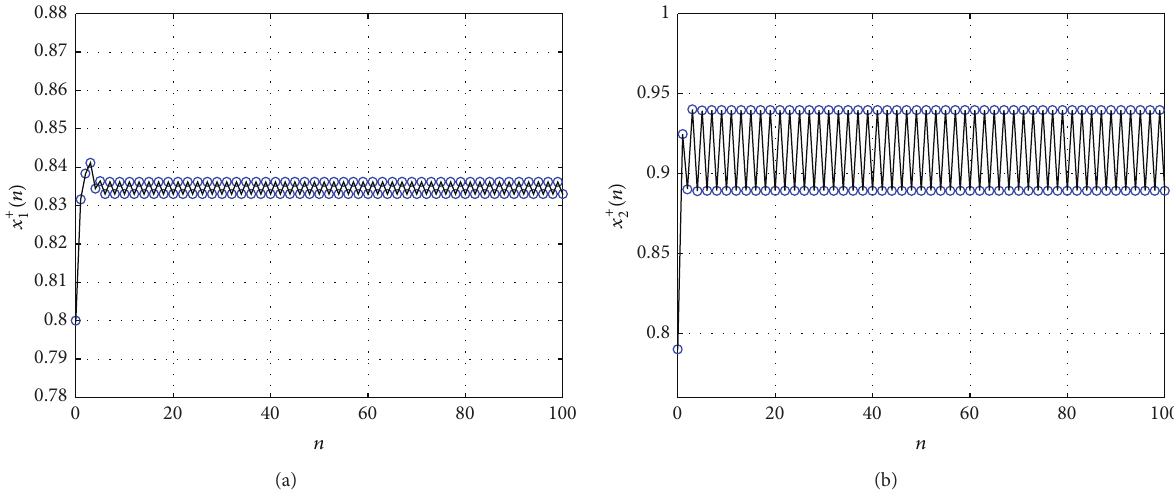
Figure 4: Positive periodic solution of system (54). (a) Time-series of 𝑥 + 1 (𝑛) with initial values 𝑥 + 1 (−1) = 0.79 and 𝑥 + 1 (0) = 0.80 for 𝑛 ∈ [0, 100] . (b) Time-series of 𝑥 + 2 (𝑛) with initial values 𝑥 + 2 (−2) = 0.85 , 𝑥 + 2 (−1) = 0.80 , and 𝑥 + 2 (0) = 0.79 for 𝑛 ∈ [0,100] .